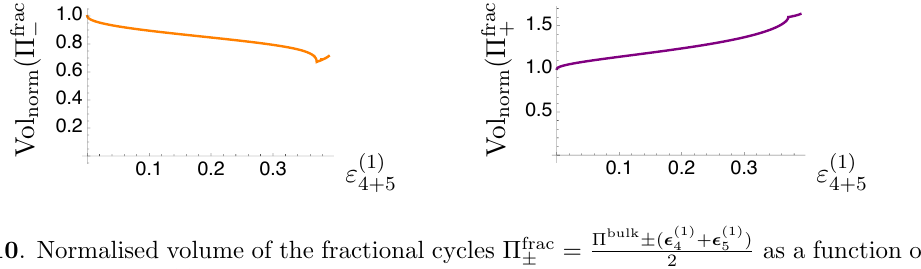
, with the bulk cycle (cid:5) bulk lying along the cycle C (cid:0) (cid:2) C + on T 4 4+5